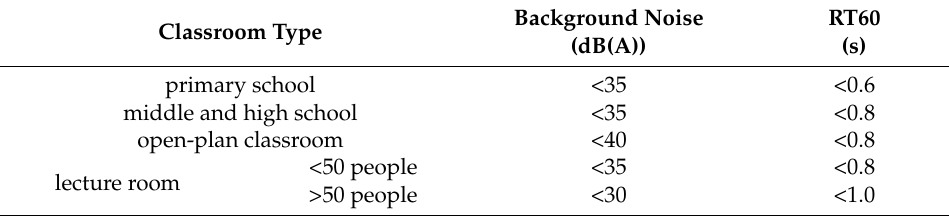
Table 2. Acoustic performance standard for classrooms in the United Kingdom